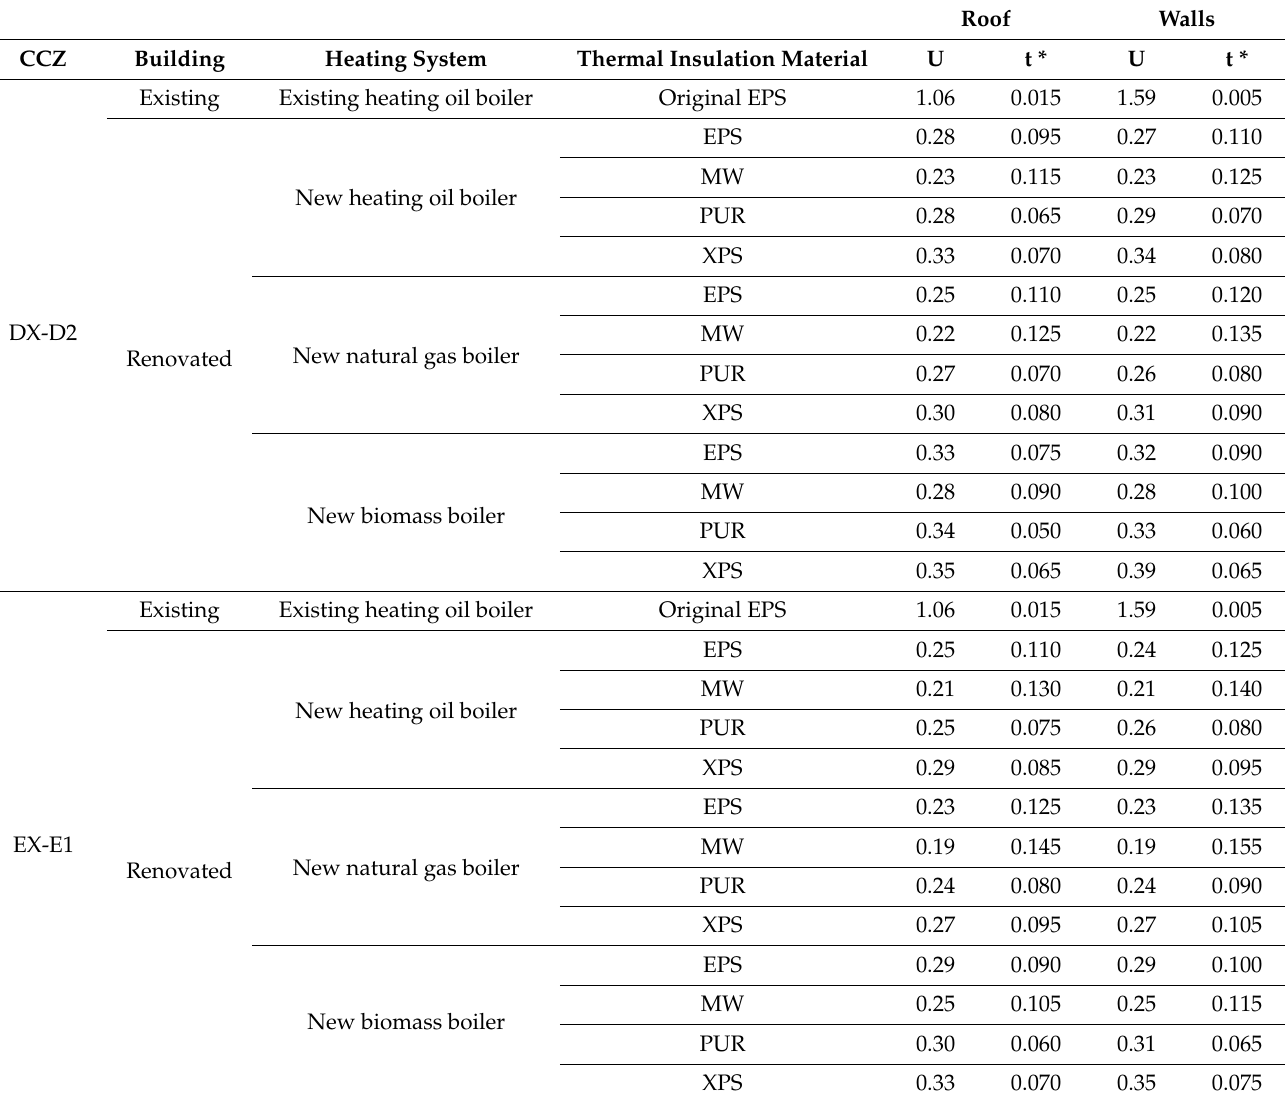
Table 5. Thermal transmittance (U), in W/m 2 · K, and thicknesses of the thermal insulation material (t), in m, for roof and walls of the existing and renovated building, by CCZ, heating system and thermal insulation